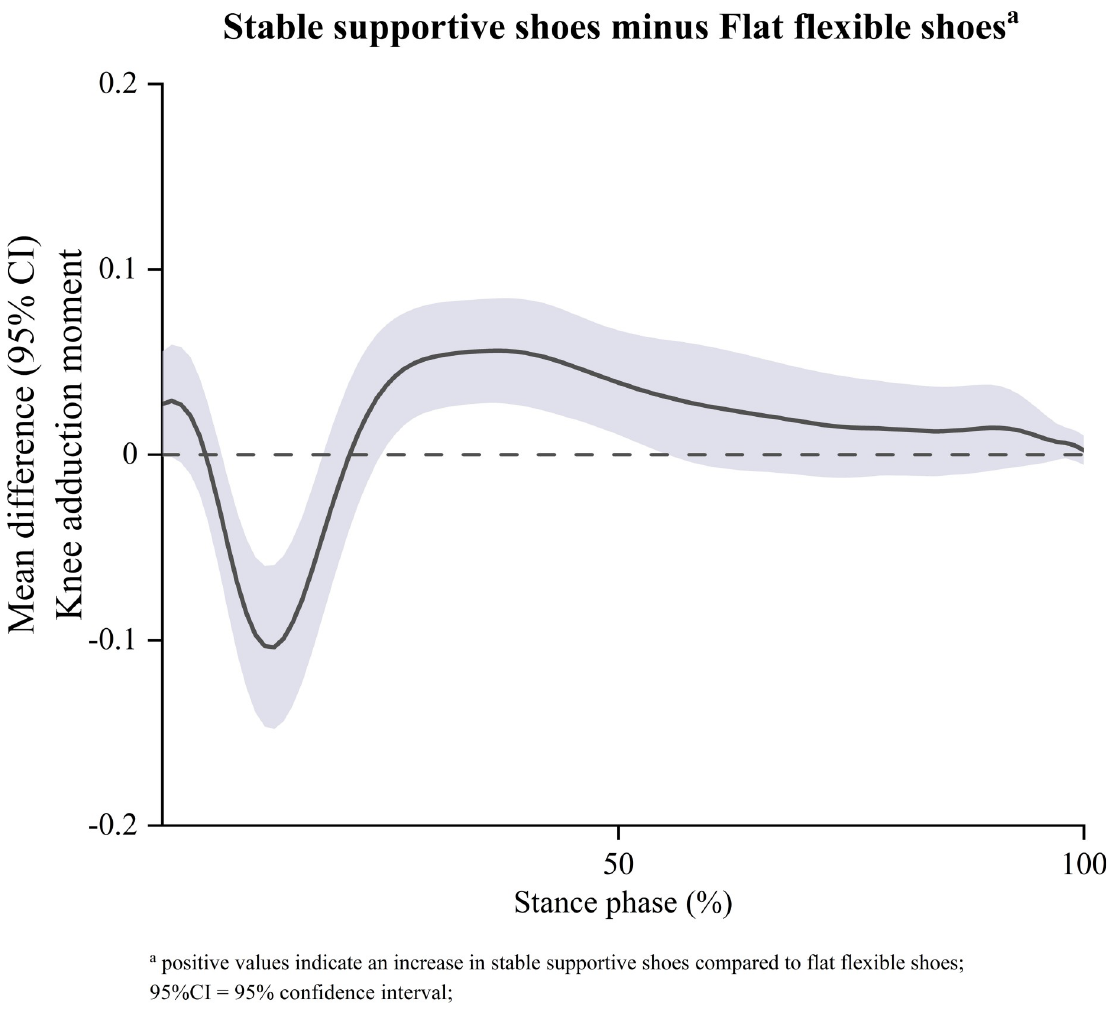
Fig 6. Mean differences (95% CI) across shoe conditions based on ANOVA post-hoc comparison of external knee adduction moment (BW).